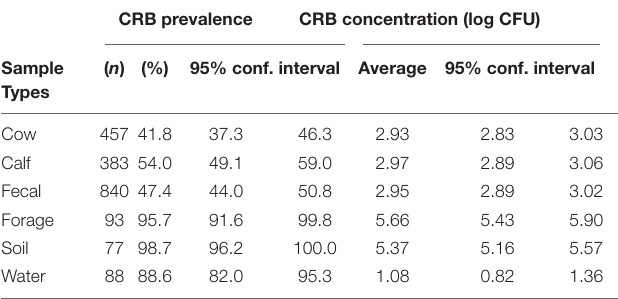
TABLE 2 | Prevalence and concentration of CRB by sample type.